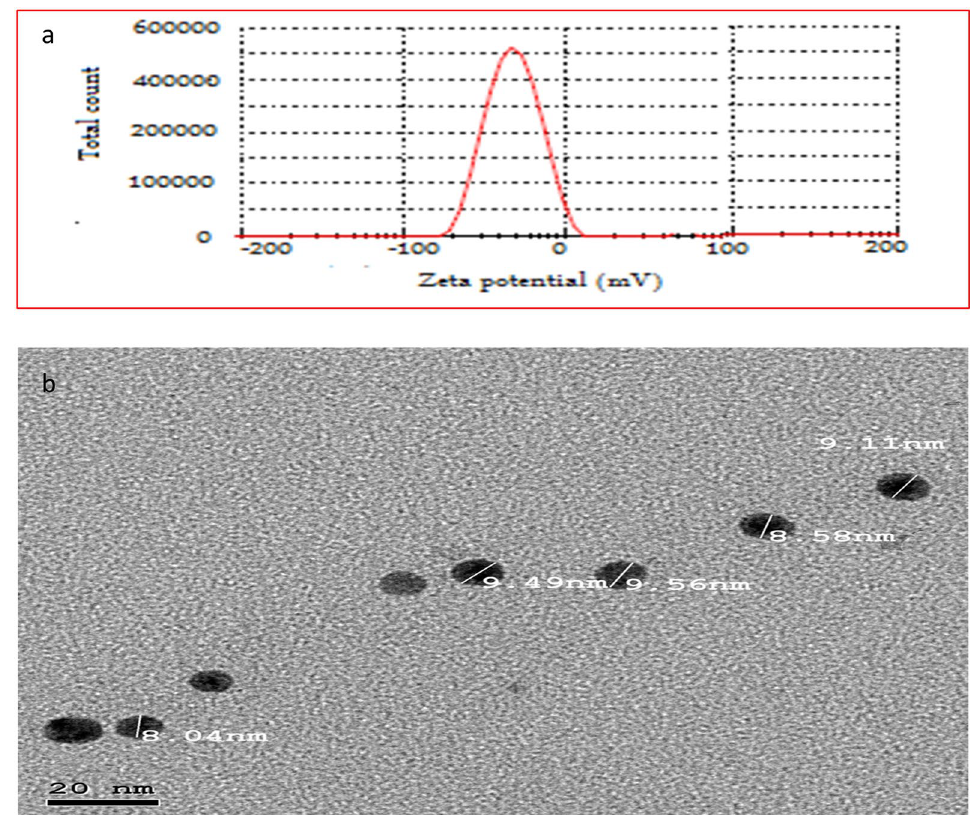
Figure 9. Zeta potential ( a ) and transmission electron microscopy (TEM, b ) of thymol